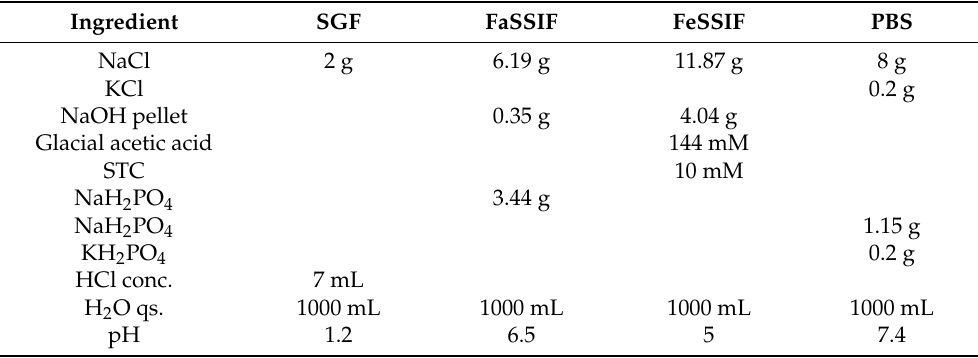
Table 2. Compositions of simulated physiological fluids used as release